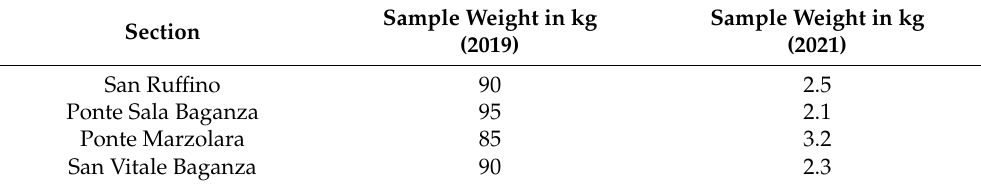
Table 3. A comparison between the quantities of material collected in two years.